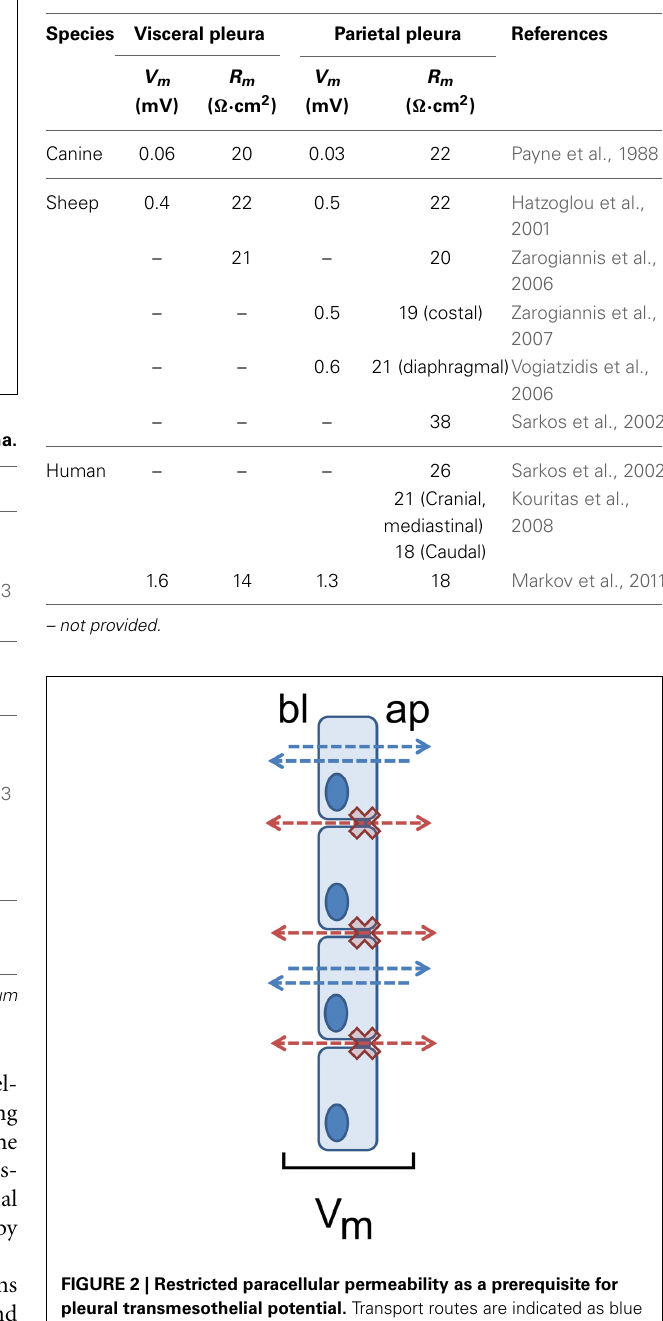
Table 2 | Comparison of transmesothelial potential ( V m ) and resistance ( R m ) values measured in different species including human tissue specimens.